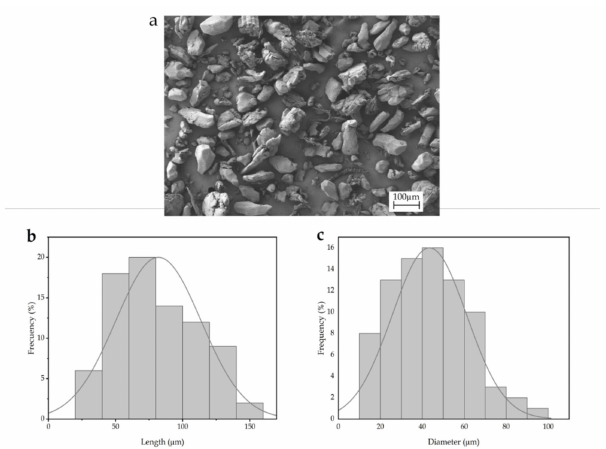
Figure 1. ( a ) Scanning electron microscope image (SEM) of micronized argan shell (MAS). Image was taken with a magnification of 100 × and a scale marker of 100 µ m; ( b ) histogram of the argan particles length; ( c ) histogram of the argan particles